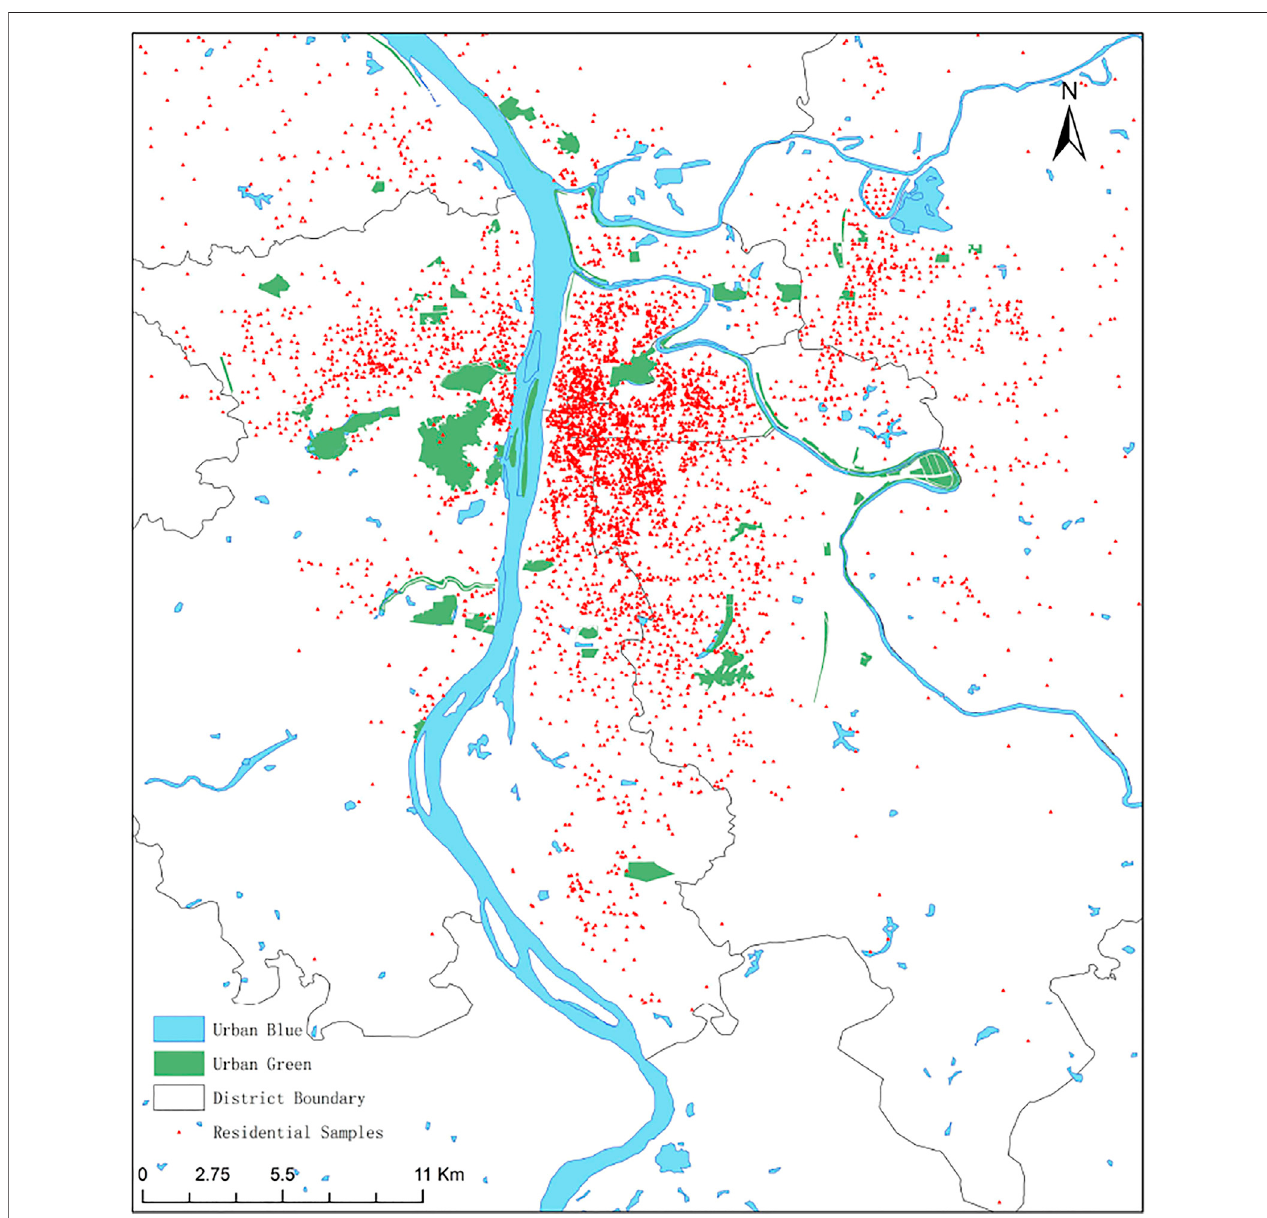
FIGURE 2 | Study area and sample residential